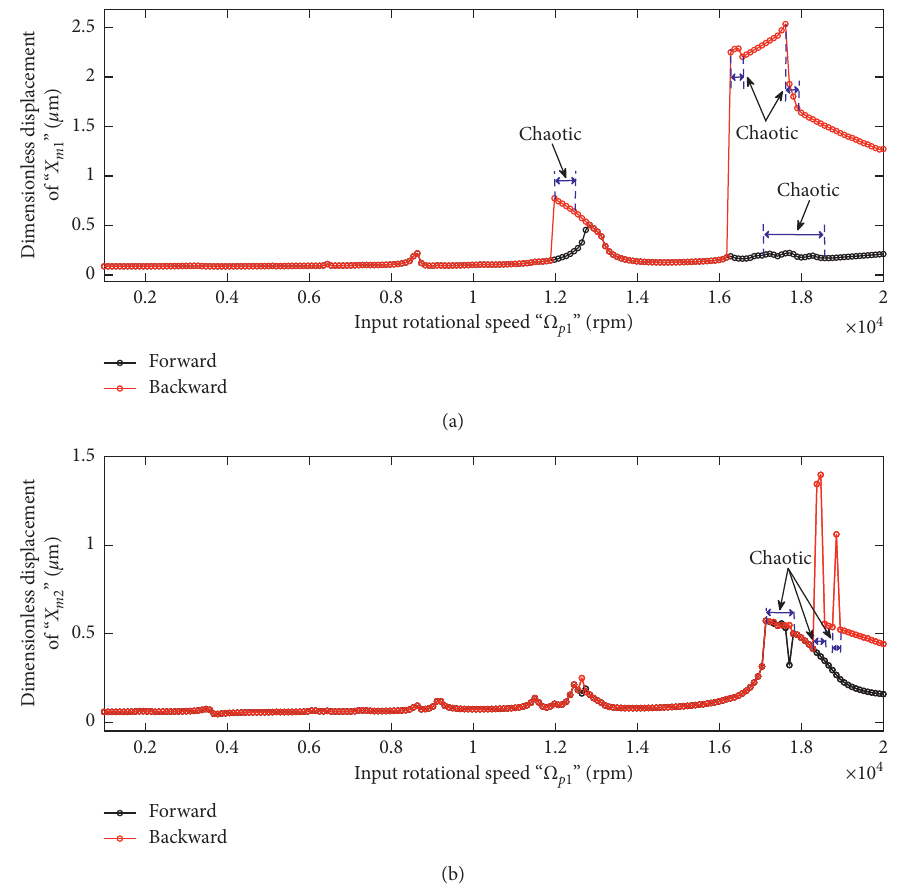
Figure 18: PPVs of forward and backward bifurcation system; s